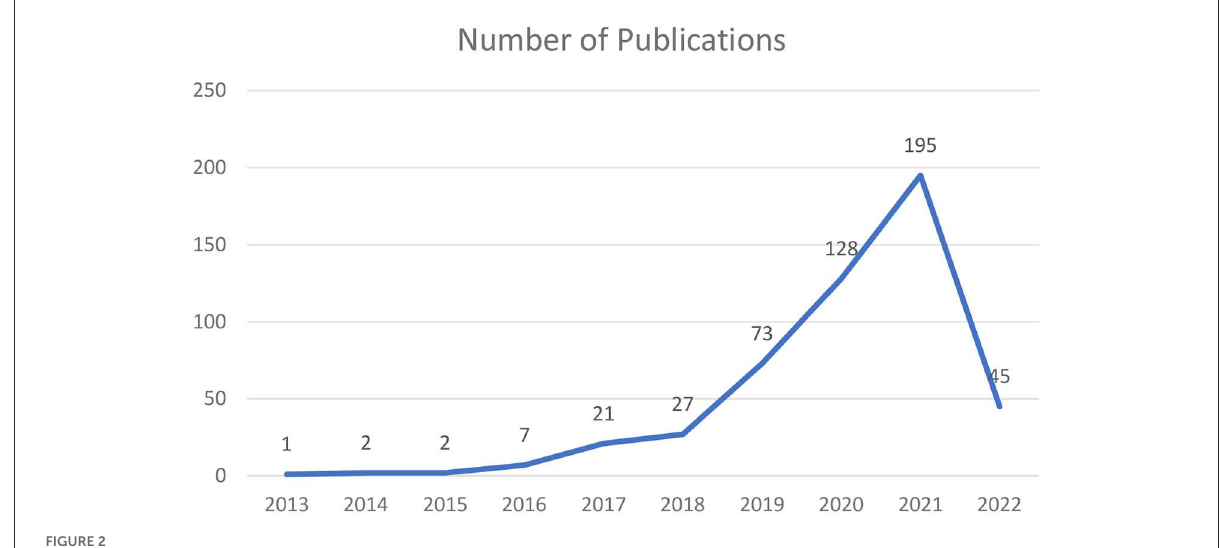
FIGURE2 Annual volume of social media addiction or social media problematic use ( n = 501).